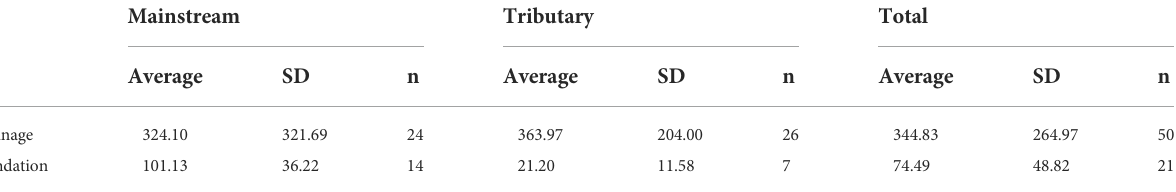
TABLE 2 The statistic data in CO 2 emission from the drawdown areas in the mainstream and tributaries of TGR in the drained and inundated seasons (mg m − 2 h − 1 ).